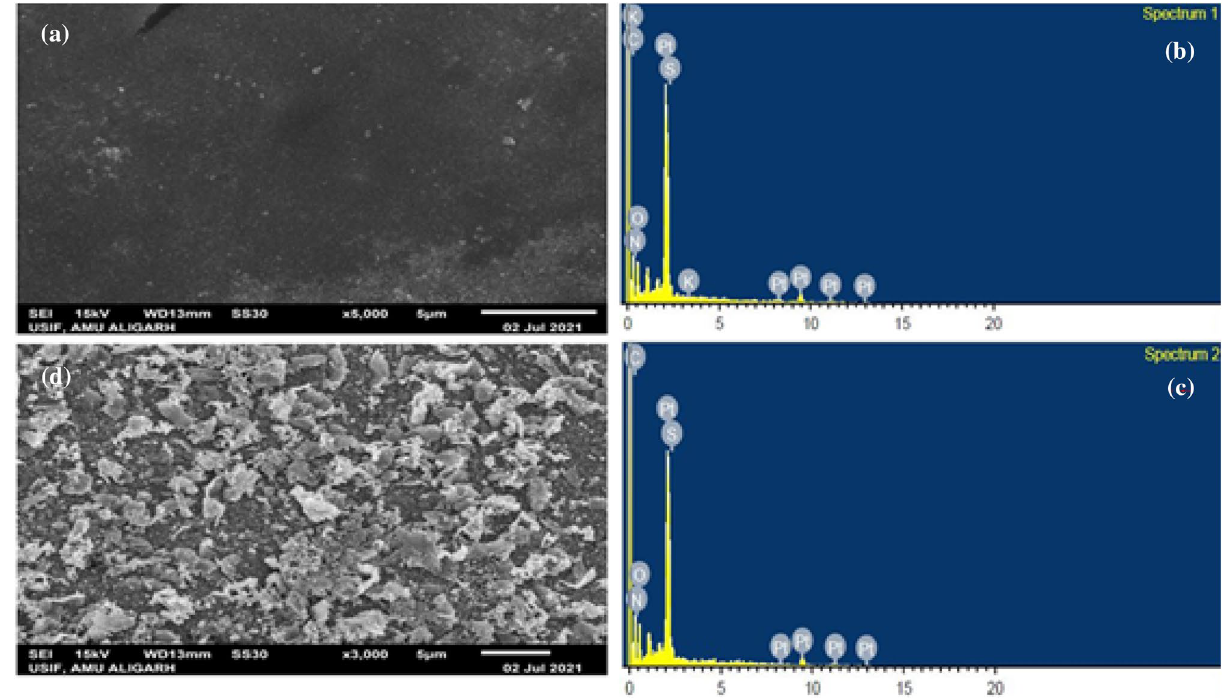
Figure 4. Represents the SEM and EDX images of the fabricated membrane ( a ) and ( c ) (SA/SPVA-PANI-Pt). ( b ) and ( d ) EDX images